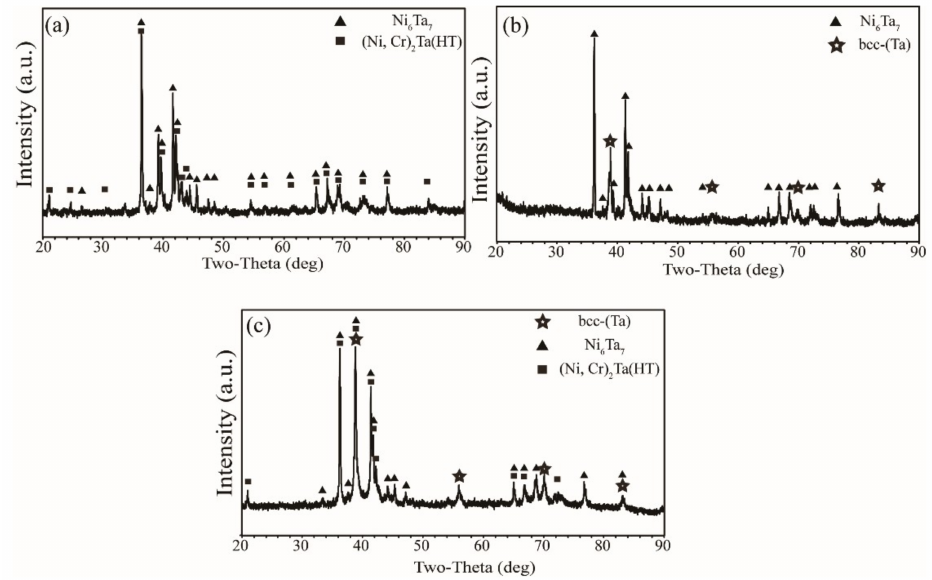
Figure 5. The XRD patterns of typical alloys in the Ni-Cr-Ta system annealed at 1300 ◦ C for 15 days. ( a ) Ni 16 Cr 38 Ta 46 ; ( b ) Ni 12 Cr 33 Ta 55 ; ( c ) Ni 5 Cr 40 Ta 55